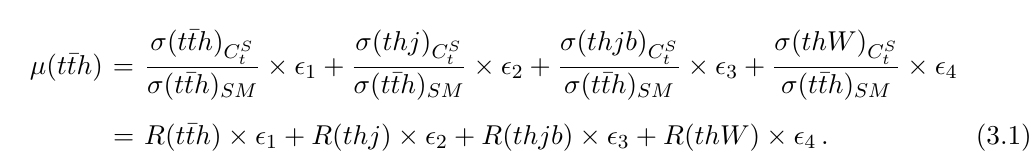
turns given by eq. (2.9) and eq. (2.10), respectively. Explicitly, we